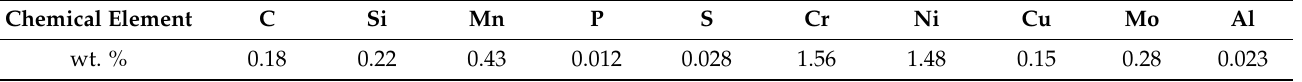
Table 1. Chemical composition of the 18CrNiMo7-6 steel